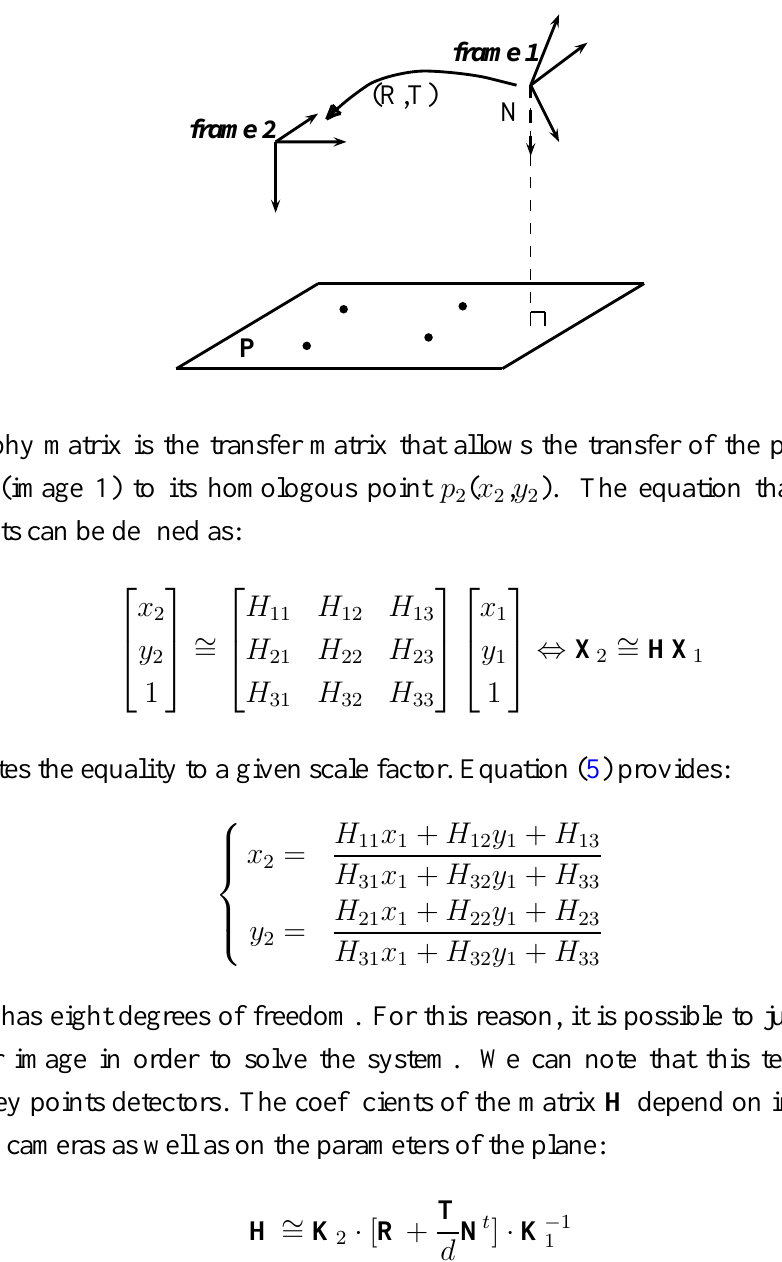
Figure 8. Homography induced by a